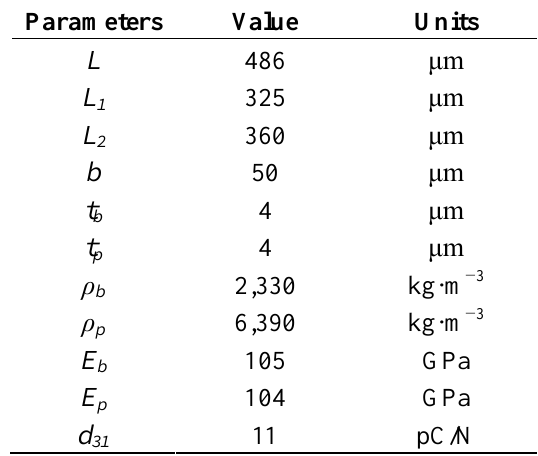
Table 1. The system parameters used for